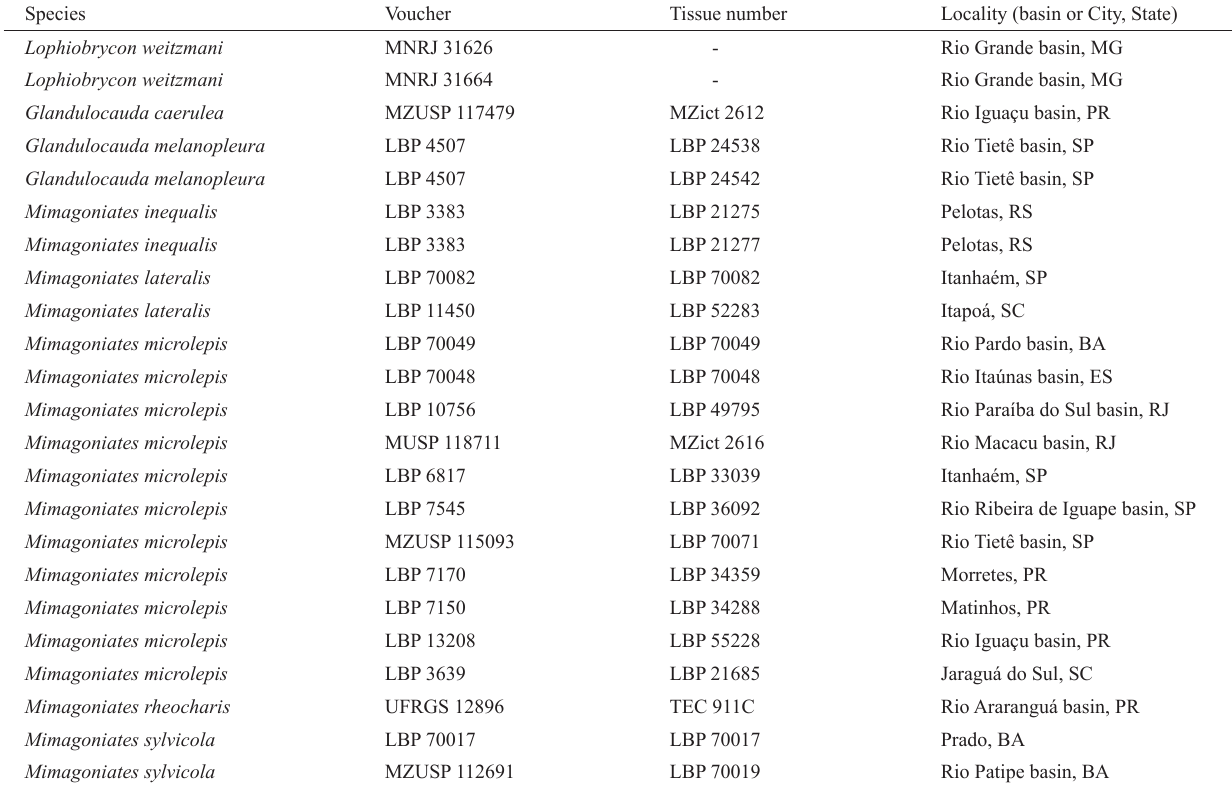
Tab. 1. Species, vouchers, tissue number, and locality information (basin or City and State) for the tissues samples of representatives of Glandulocaudini used in this study. All samples from Brazil, BA = Bahia, ES = Espírito Santo, MG = Minas Gerais, PR = Paraná, RS = Rio Grande do Sul, SC = Santa Catarina, and SP = São Paulo States. [GenBank accession number ranges: 16S = MG958088-MG958090/MG953575-MG953592; COI = MG967567-MG967588; RAG2 = MG967589-MG967609; and L . weitzmani : 16S = KF209982- KF209983; COI = KF210232- KF210233; and RAG 2 = KF211223-